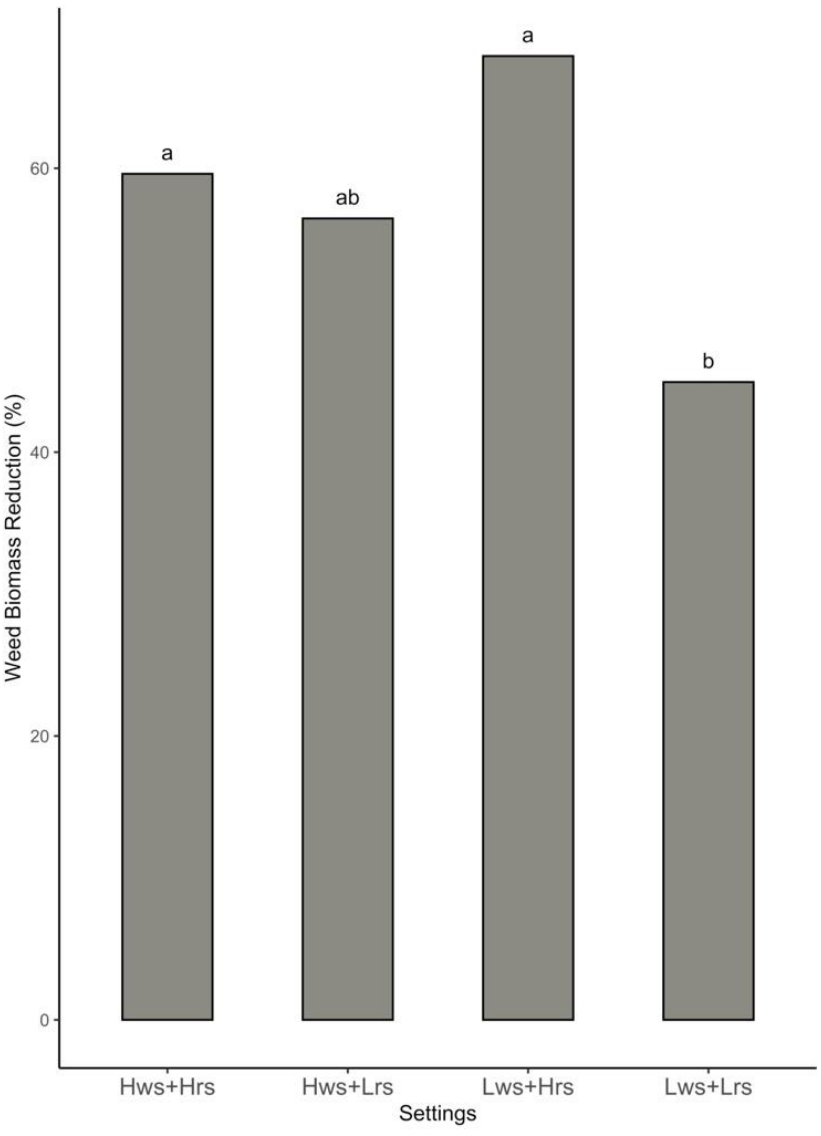
Figure 10. Effect of setting configuration on weed biomass reduction. Means denoted by different letters are significantly different at p < 0.05 (LSD test). Hws—High working speed; Lws—low working speed; Hrs—high rotation speed; Lrs—low rotation speed.